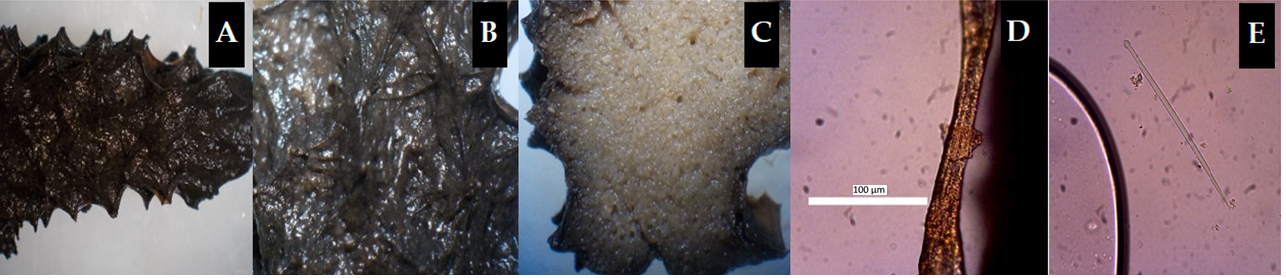
Figure 2. The morphology of marine sponge Hyrtios erectus (Sp2): ( A ) consistency; ( B ) surface; ( C ) choanosomes; ( D ) skeleton; ( E ) spicules (10 × ).